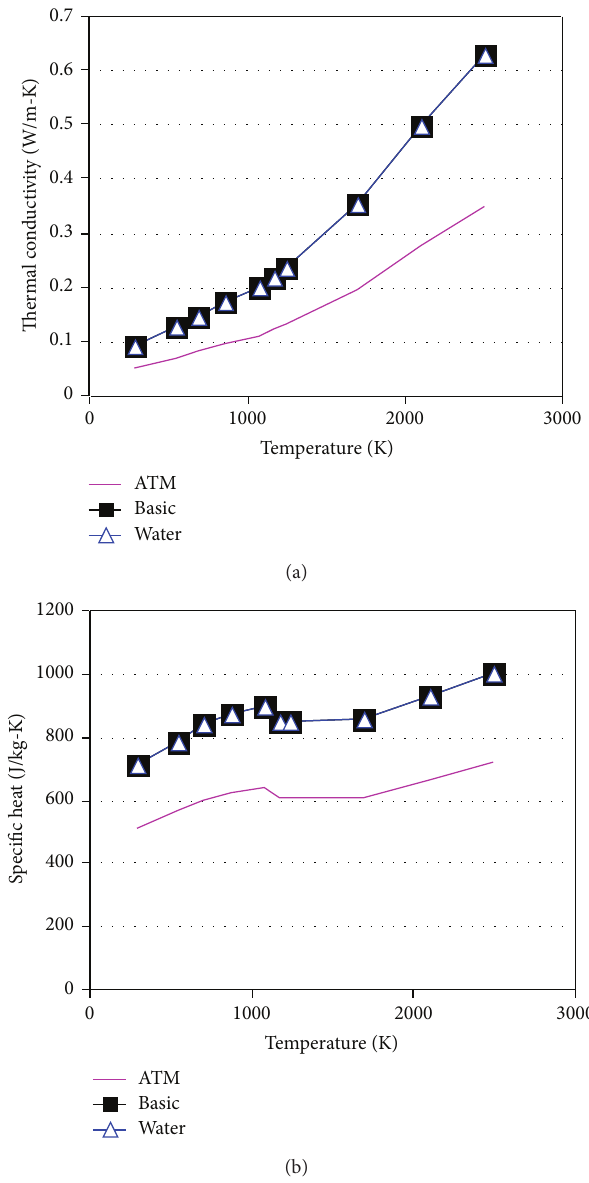
Figure 7: The thermal properties of ZrO 2 shroud layer: (a) thermal conductivity, (b) specific